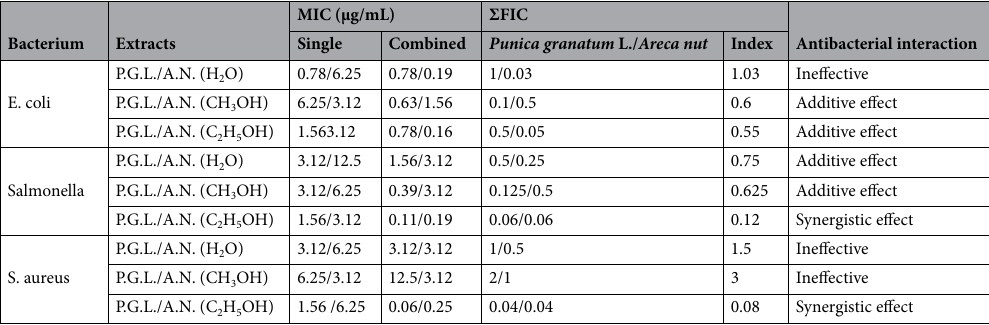
Table 2. Results of FIC